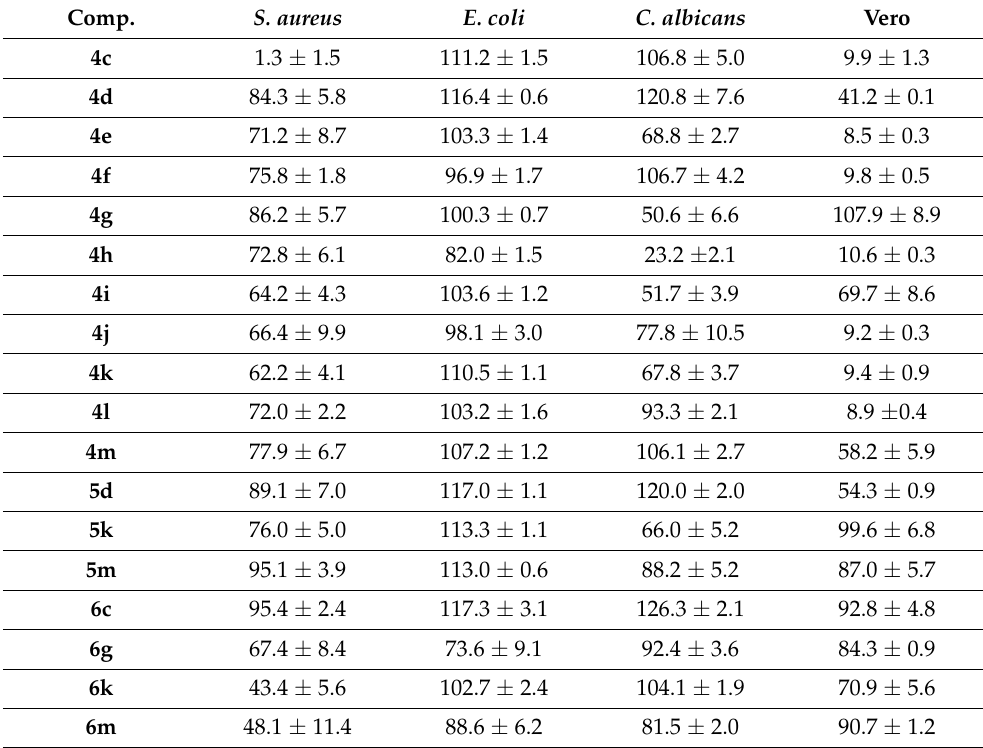
Table 2. Microbial growth and cell proliferation (mean values and standard deviations).